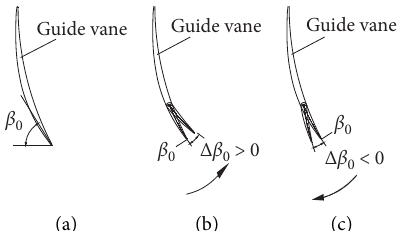
Figure 6: The datum and turn direction for adjusting the guide vane inlet angle. (a) Inlet angle of the guide vane. (b) Counterclockwise rotation. (c) Clockwise rotation.